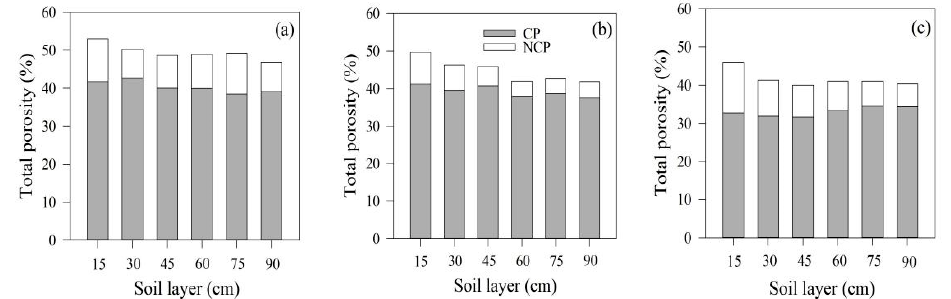
Figure 4. Soil porosity distribution of the 0–90 cm soil layer of BF ( a ), MF ( b ) and PF ( c ). Abbreviations: TP, total porosity; CP, capillary porosity; NCP, noncapillary porosity; PF, Pinus massoniana forest; MF, mixed Pinus massoniana / broad-leaved forest; BF, monsoon evergreen broad-leaved forest.